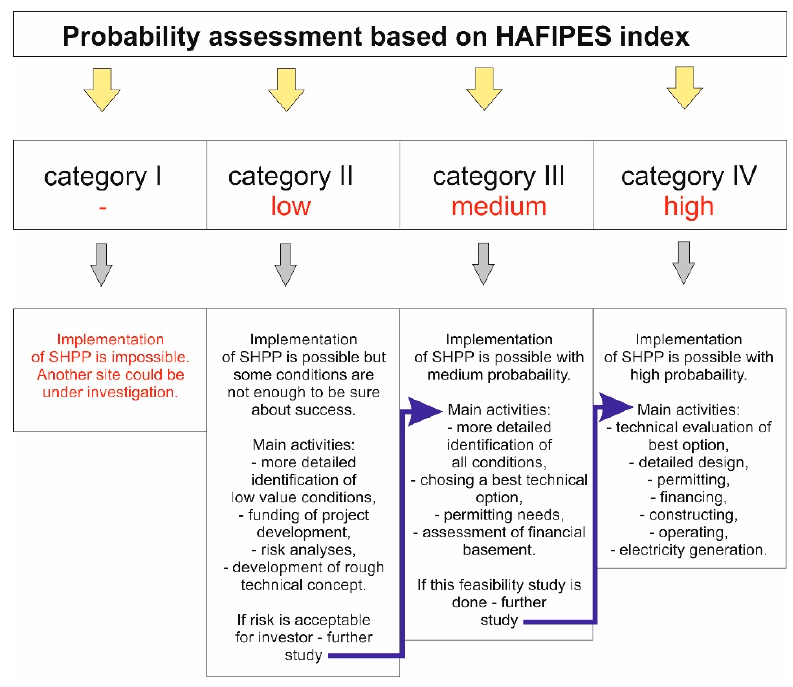
Figure 6. SHPPs development steps based on probability assessment.